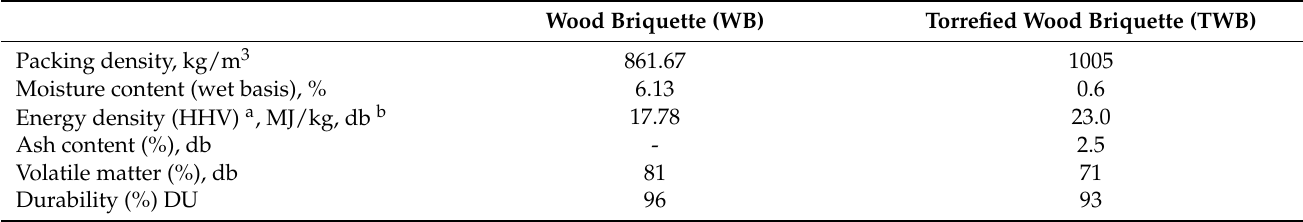
Table 1. Properties of wood briquette (WB) and torrefied wood briquette (TWB) products.